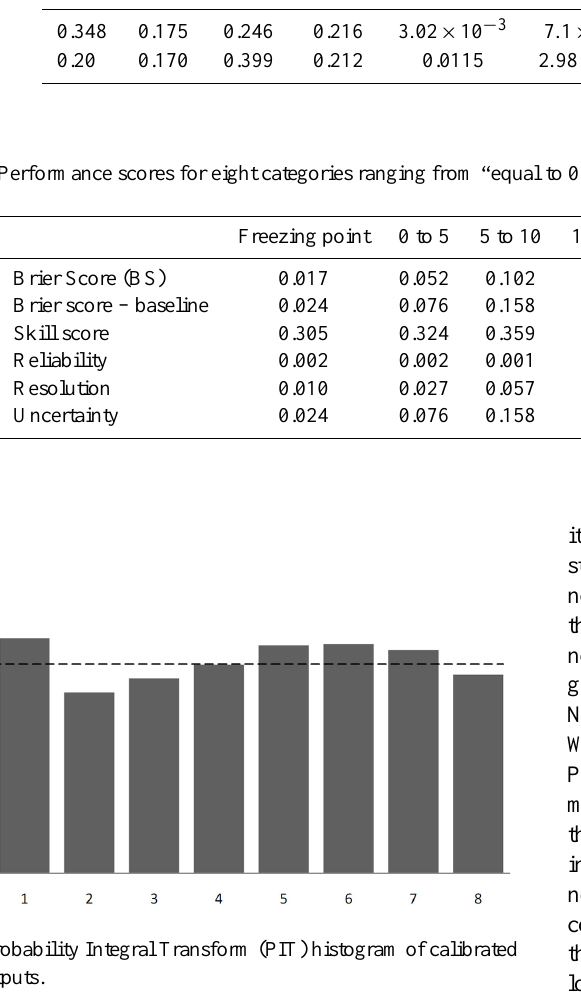
Table 2. Weights of two synoptic stations of Piranshahr and Noshahr in initialized at 12:00UTC on 1 February and 1 May 2009, respectively. HRM